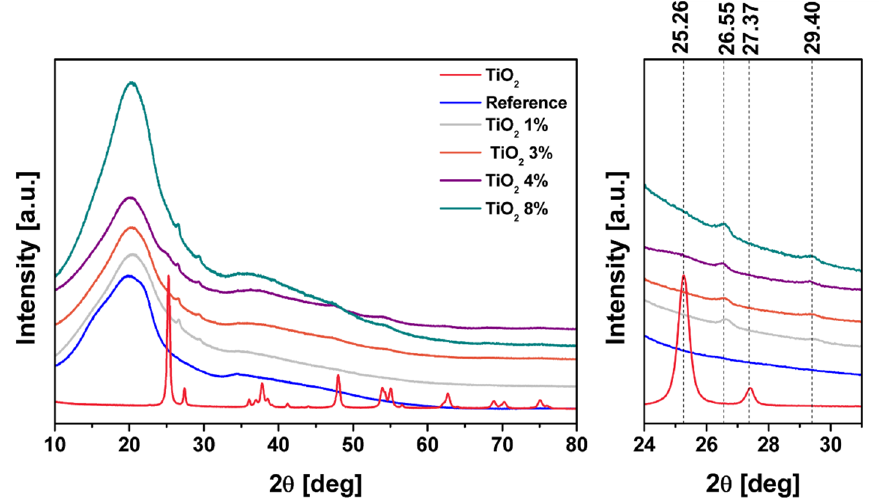
Figure 5. X-ray diffraction spectra of all samples.